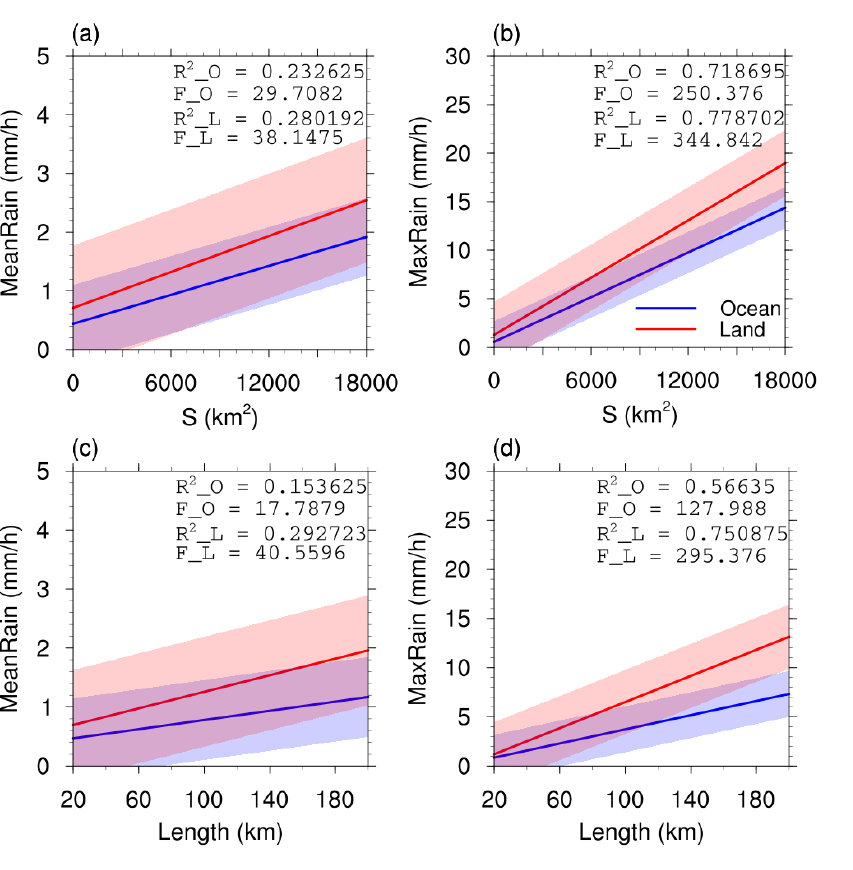
Figure 9. Relationship between the parameters of oceanic and continental rain clusters and the rain intensity: ( a ) S and the mean rain rate, ( b ) S and the maximum rain rate, ( c ) length and the mean rain rate and ( d ) length and the maximum rain rate. The blue and red lines represent the regression line of oceanic and continental rain clusters, respectively, and the blue- and red-shaded areas represent the 95% prediction intervals of oceanic and continental rain clusters, respectively. R2_O and F_O represent the R 2 and F values of the oceanic regression line; R2_L and F_L are the R 2 and F values of the continental regression line.